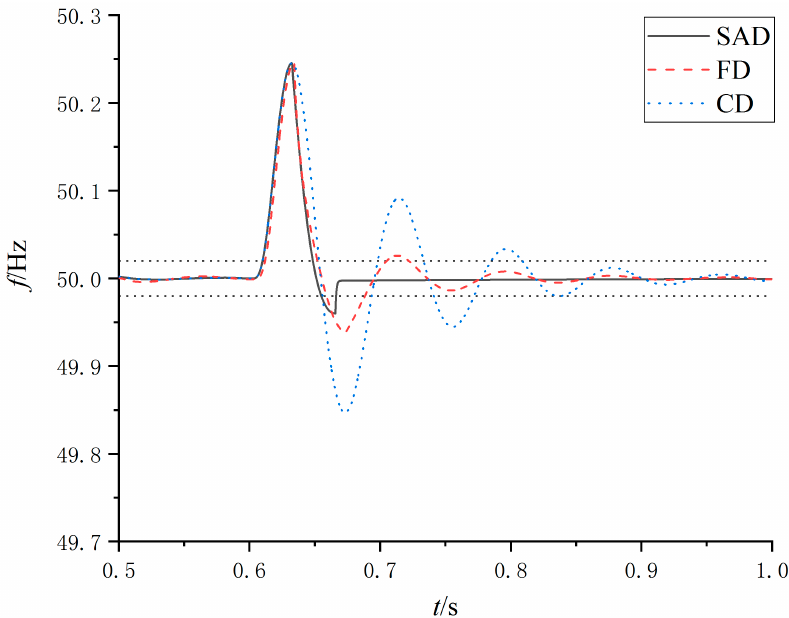
Figure 8. Comparison of frequency under different damping control strategies when load decreases.